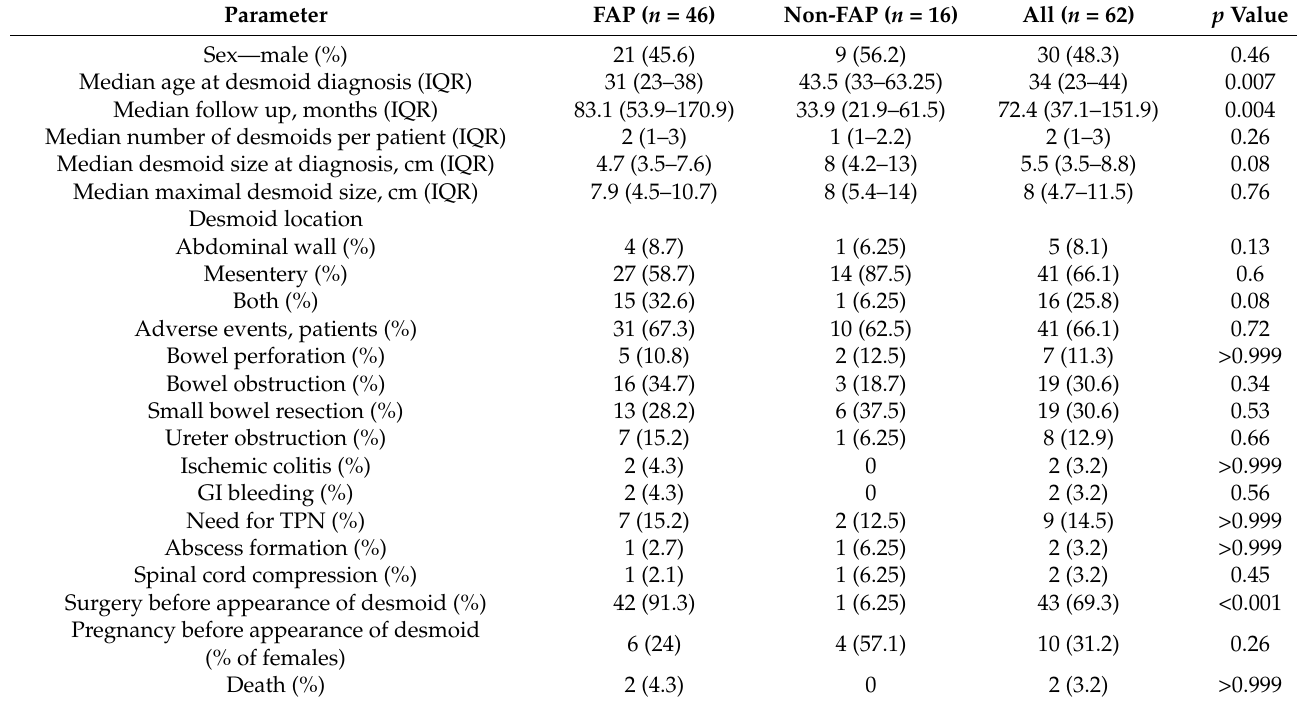
Table 1. Basic characteristics of the study population and complications among FAP and non-FAP